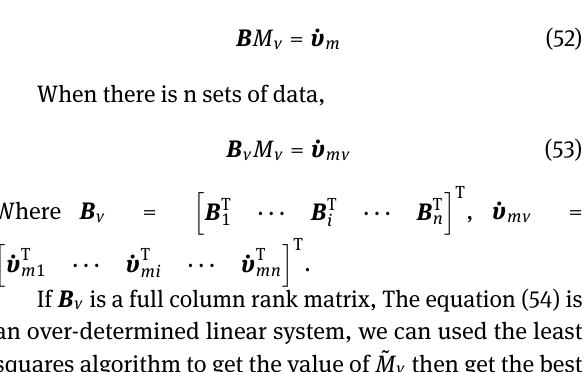
Then equation (51)